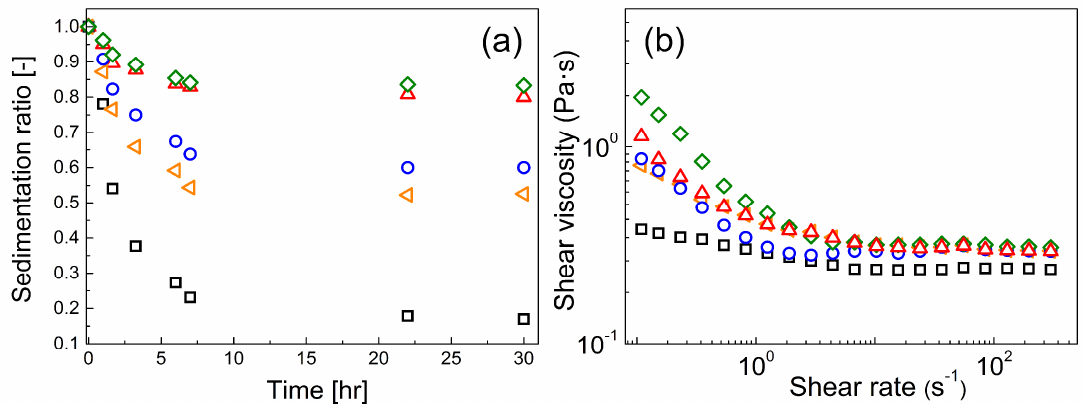
Figure 6. ( a ) Sedimentation ratio and ( b ) off-state viscosity in the absence of the external electric field for: ( □ ) neat GO, ( ⊲ ) GO-PMMA, ( 〇 ) GO-PBMA, ( △ ) GO-PGMA, (◊) GO-PHEMATMS.